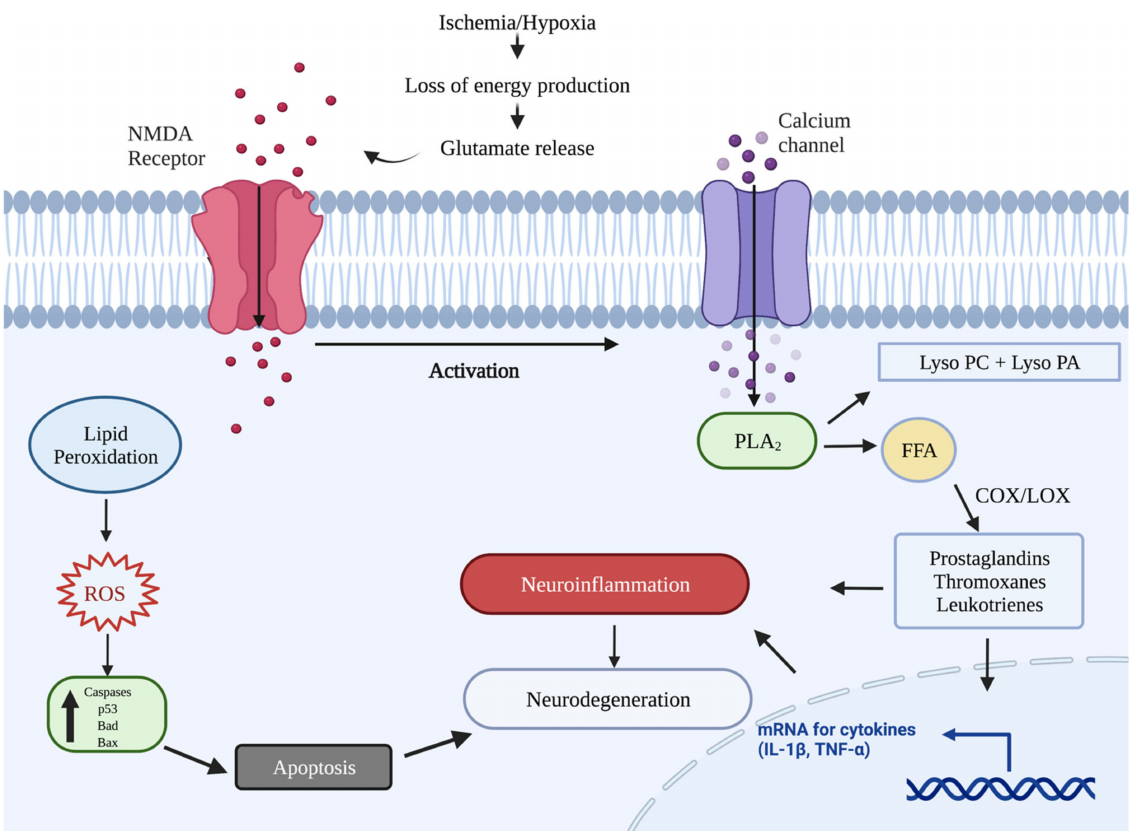
Figure 3. The underlying pathophysiological changes after TBI leading to neuroinflammation, increased oxidative stress and neuronal death. The increased oxygen requirements of the brain remain unmet due to TBI-induced hypoxia and ischemia that cause increased lipid peroxidation, which generate reactive oxygen species (ROS) and upregulation of pro- apoptotic proteins. The increased glutamate results in increased Ca 2+ uptake and excitotoxicity, resulting in mitochondrial dysfunction and necrotic cell death. The overactivated phospholipase A 2 causes the catalysis of membrane phospholipids into lysophosphatidylcholine (lyso-PC), lysophosphatidic acid (lyso PA) and free fatty acids i.e., arachidonic acid. These primary metabolites are bioactive and converted in platelet activating factors. The arachidonic acid undergoes the COX/LOX pathway to yield eicosanoids causing upregulation of inflammatory cytokines. Red dots are showing the Glutamate neurotransmitter and purple dots are showing the Calcium. This figure was created with BioRender.com (accessed on 9 September